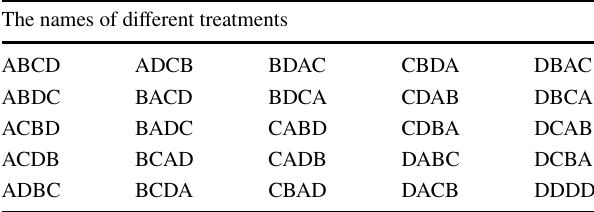
Table 4 The names of different treatments related to the amounts of irrigation in the four stages of plant growth The names of different treatments